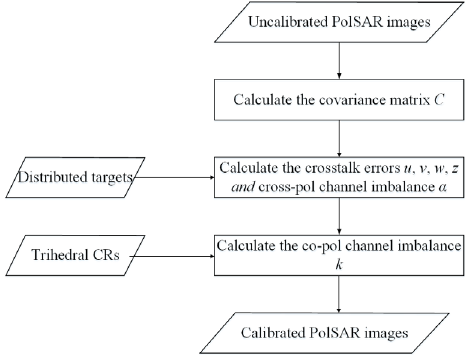
Figure 1 . Flow chart of the Quegan